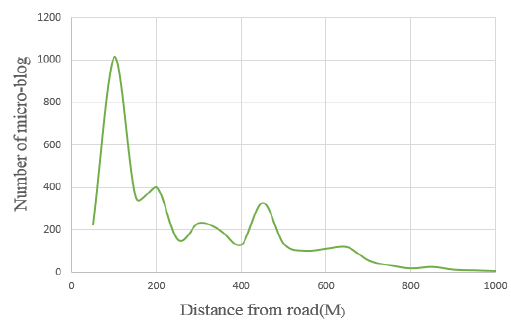
Figure 4 Microblogging number varied with distance from the road in Lushan Natural Reserve